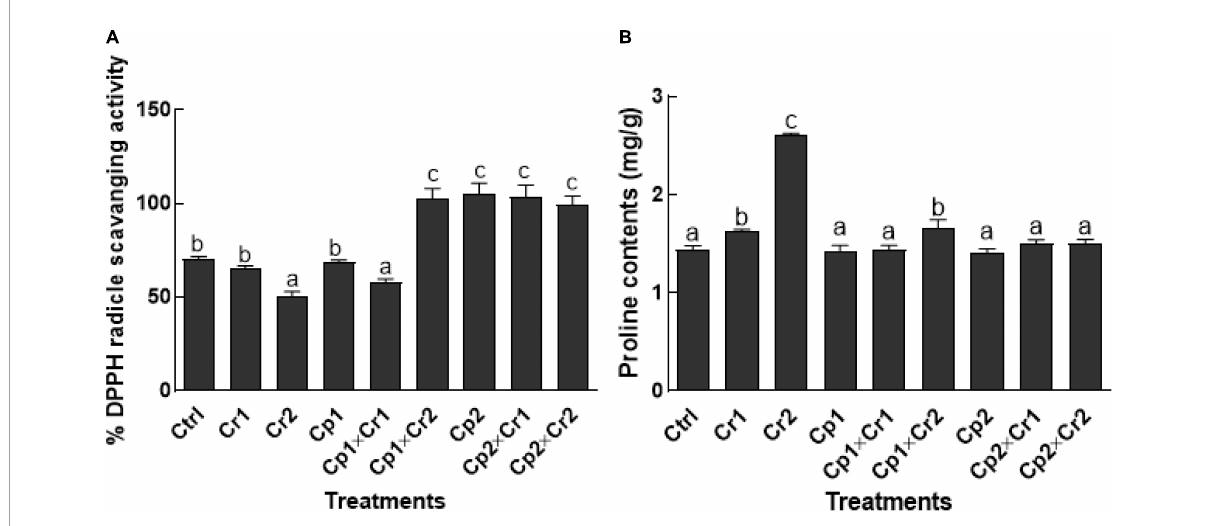
FIGURE5 (A) 2,2-diphenyl-1-picrylhydrazyl radical (DPPH) radical scavenging activity; (B) Proline contents of 15-days-old soybean plants after treatment with endophytes Cp1 and Cp2 exposed to chromate stress. Cp1 = Stemphylium lycopersici ; Cp2 = Stemphylium solani ; Ctrl = control; Cr1 = 10 ppm chromium; Cr2 = 50 ppm chromium. Each bar represents mean of triplicated data ( n = 3) with standard error. Bars that are labeled with different letters are significantly different at p < 0.05 computed by Duncan multiple range test.